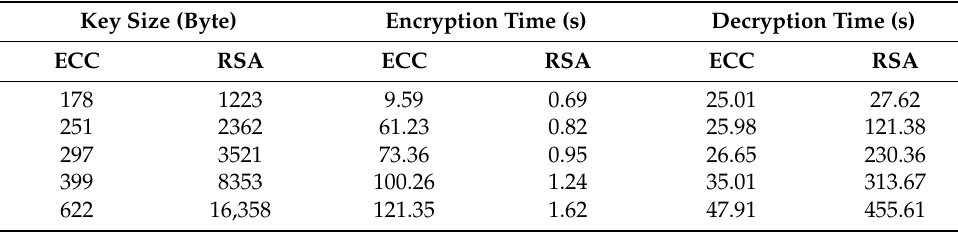
Table 7. Performance comparison of ECC and RSA.